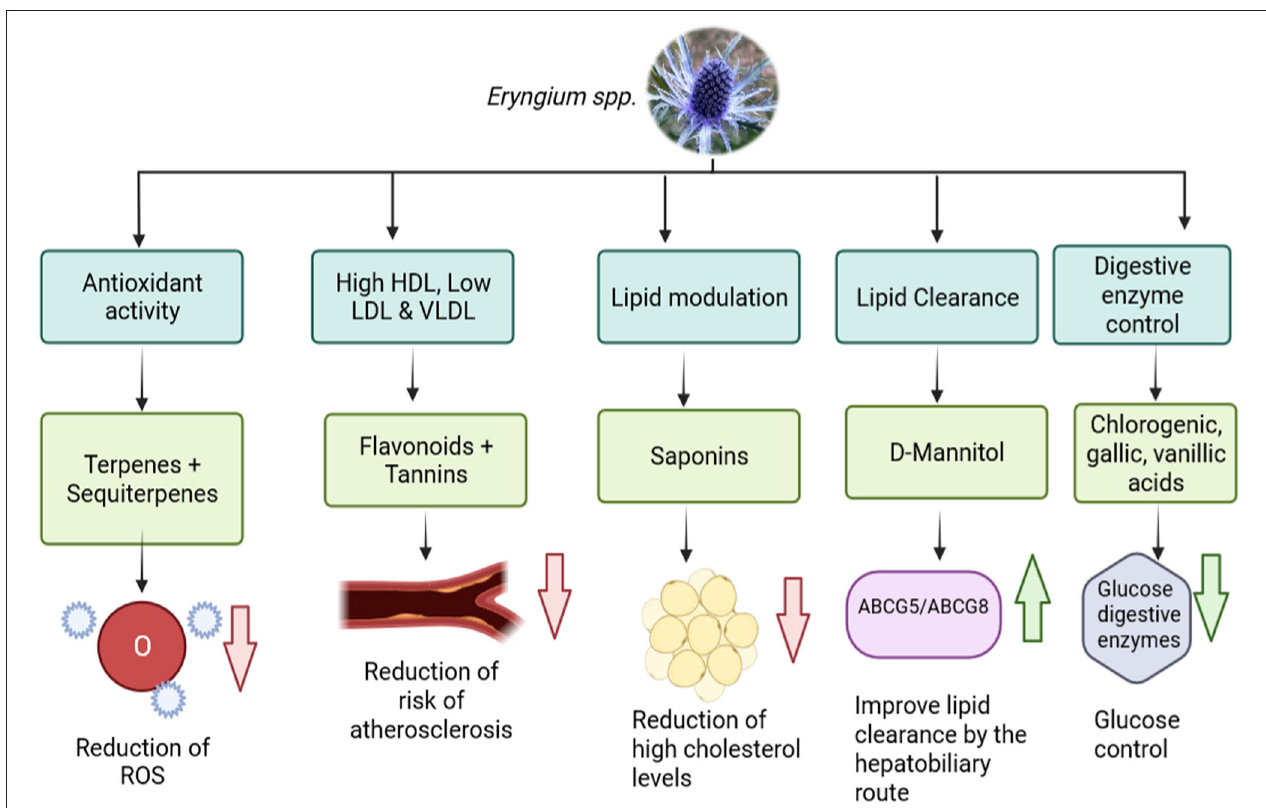
FIGURE 3 | Benefits of the phytocomponents of Eryngium spp. with lipid and glucose control (ROS, Reactive Oxygen Species; NPC1L1, Niemann-Pick C1-Like 1; ABCG5, ATP-Binding Cassette Subfamily G Member 5; ABCG8, ATP-Binding Cassette Subfamily G Member 8) (Created in BioRender).